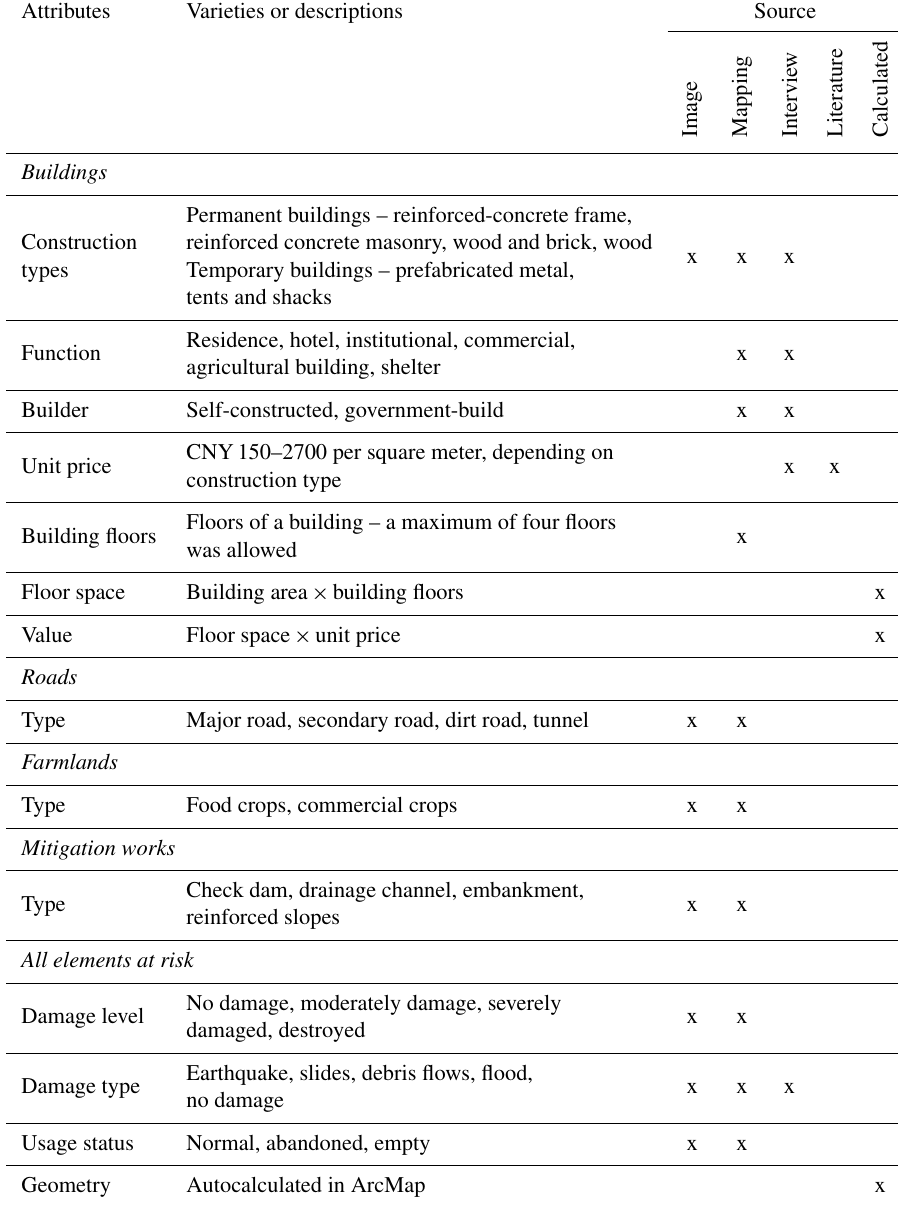
Table 2. Attributes of the elements-at-risk inventories and the main methods of collection (image is image interpretation; mapping is field mapping; interview is interviews with local people and authorities; literature is various published and unpublished sources; calculated is calculated from other